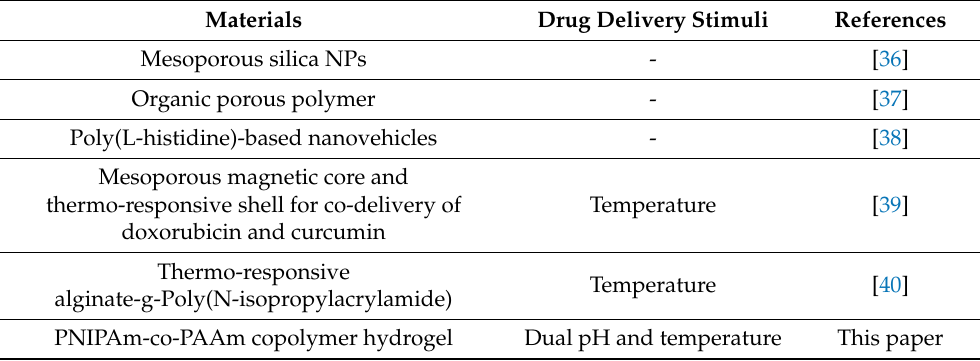
Table 1. Comparison of PNIPAm-co-PAAm hydrogel and other doping materials.